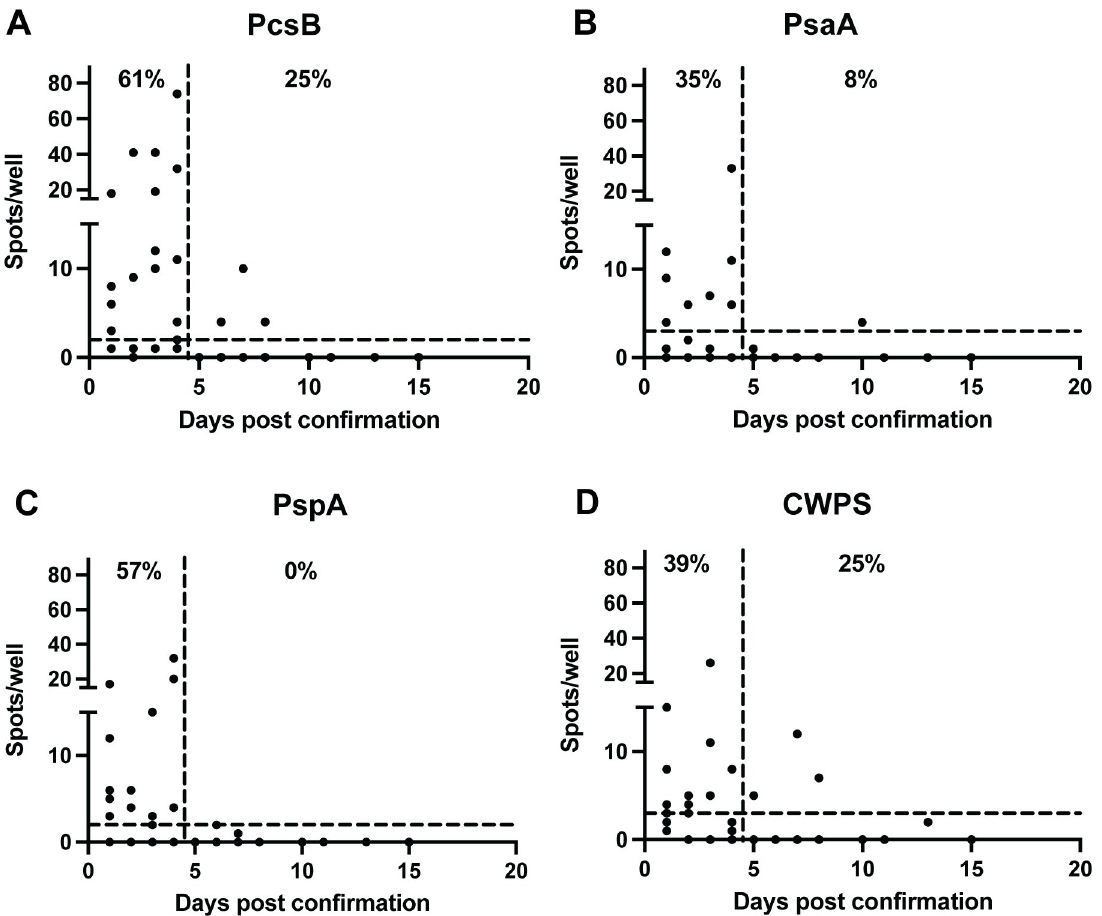
Fig 3. Circulating antibody secreting cells are detectable primarily in the first four days post-confirmation. Time course of pathogen- specific IgG responses to S . pneumoniae antigens PcsB (A), PsaA (B), PspA (C), and CWPS (D). Days of sample collection are presented on the x-axis as days post-confirmation from the Emory Hospital Medical Microbiology Laboratory. The dashed horizontal line represents the C 0 , the minimum number of spots for a positive sample. The C 0 was determined for each antigen as PcsB:2, PsaA:3, PspA:2, CWPS:3. The dashed vertical line indicates Day 4.5, the observed time after which most samples no longer had circulating